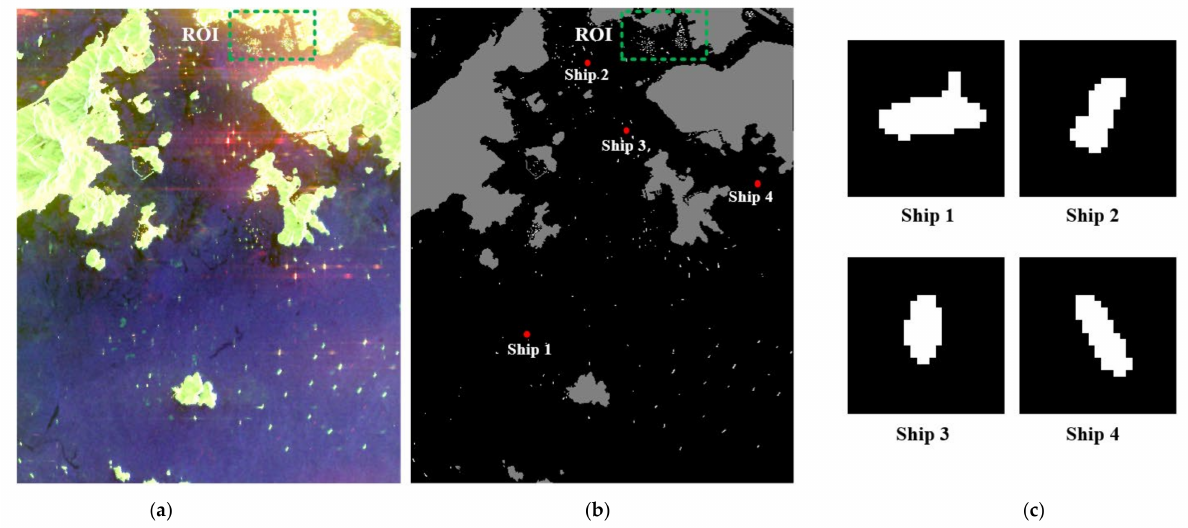
Figure 1. Radarsat-2 PolSAR dataset. ( a ) Pauli RGB image. ( b ) Ground-truth image. ( c ) Ground-truth images of selected ship